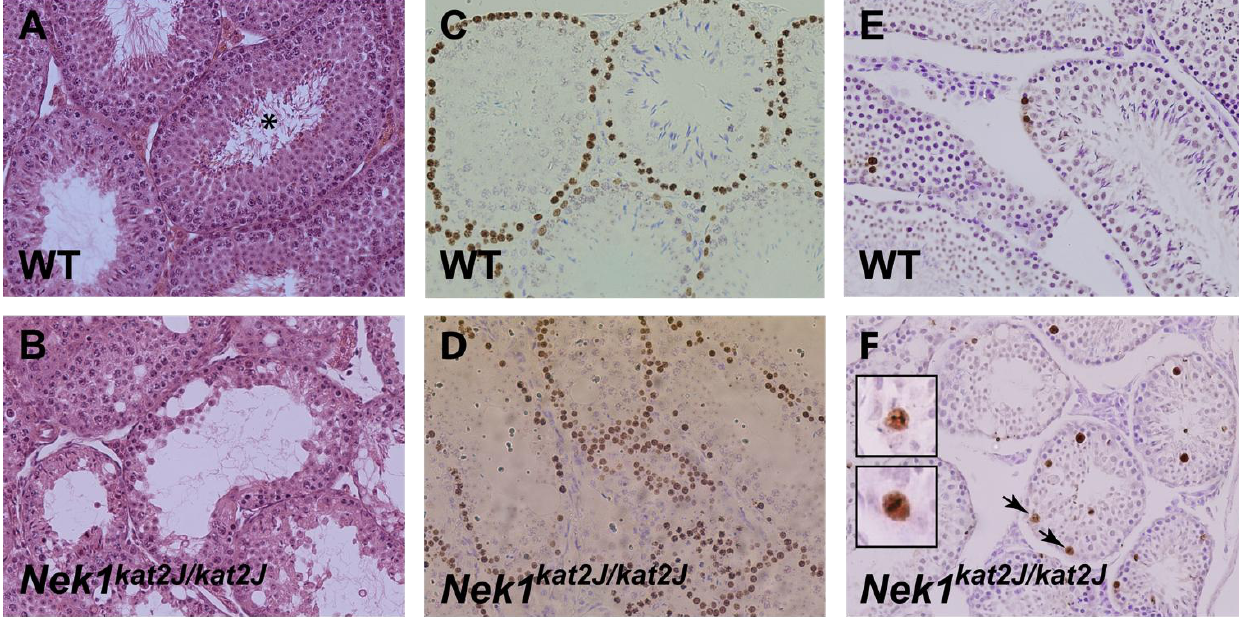
Figure 3. 8 week old Nek1 kat2J/kat2J mice show disorganized testes morphology and an increase in apoptotic cells. 8 week old wild type ( A , C , E ) and Nek1 kat2J/kat2J ( B , D , F